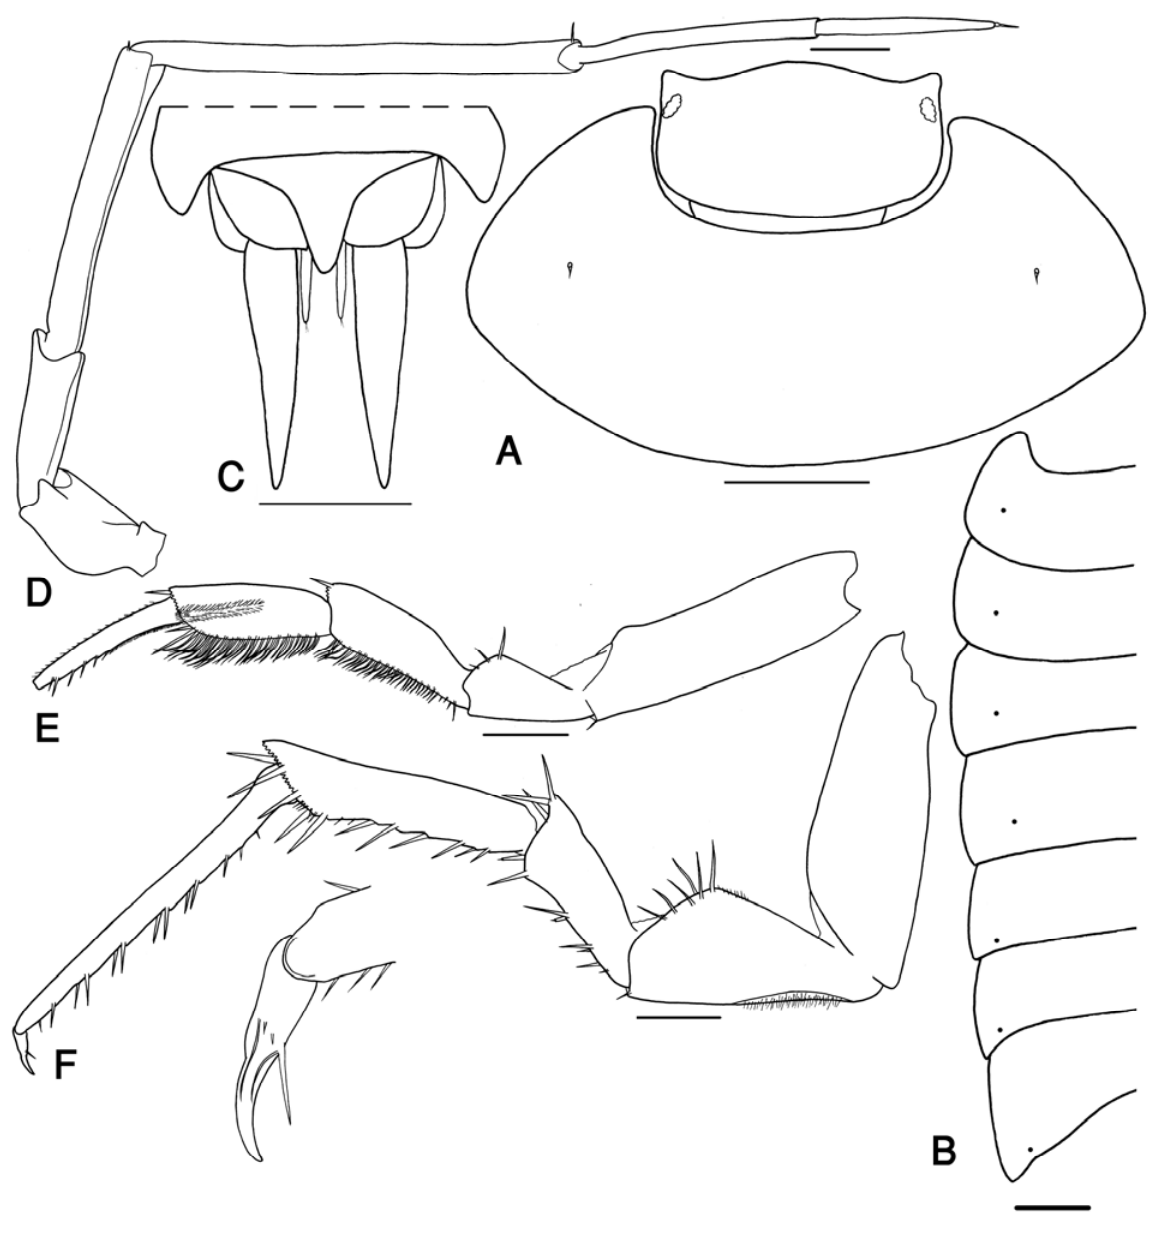
F IGURE 3. Protracheoniscus faramarzi n. sp., A-C, female paratype, 13 mm; D-F, male, holotype, 11 mm. A, cephalon and first pereonite; B, left side of pereon showing disposition of noduli laterales; C, telson and uropods; D, antenna; E, pereopod I; F, pereopod VII. Scales = A-C, 1 mm; D-F, 0.5